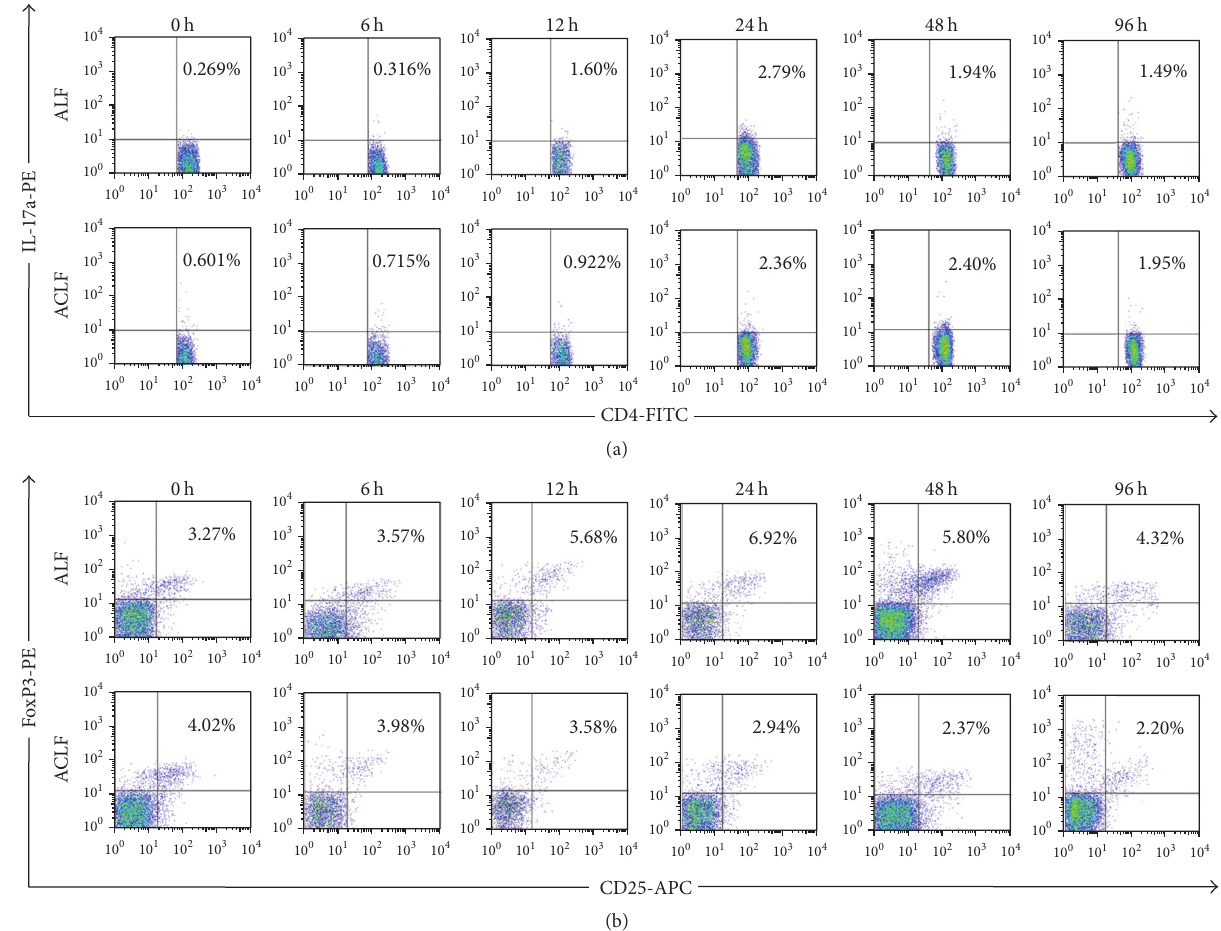
Figure 4: Th17 and Treg cells in peripheral blood in ACLF group and ALF group. (a) Th17 cells; (b) Treg cells (Th17 cells: T helper 17 cells; Treg cells: T regulatory cells).